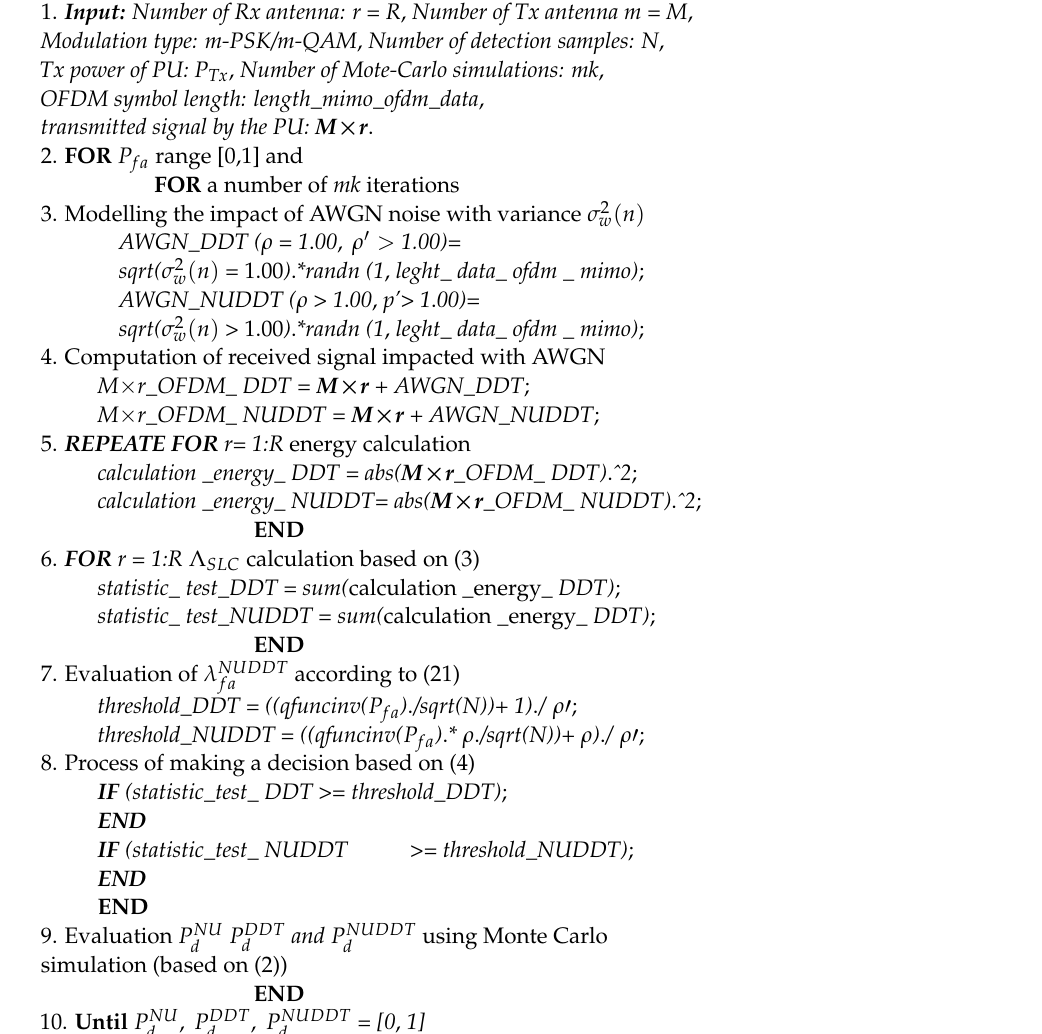
Algorithm 1. Simulation phases of the ED SS employing SLC with one PU and one SU in a wireless communication system.